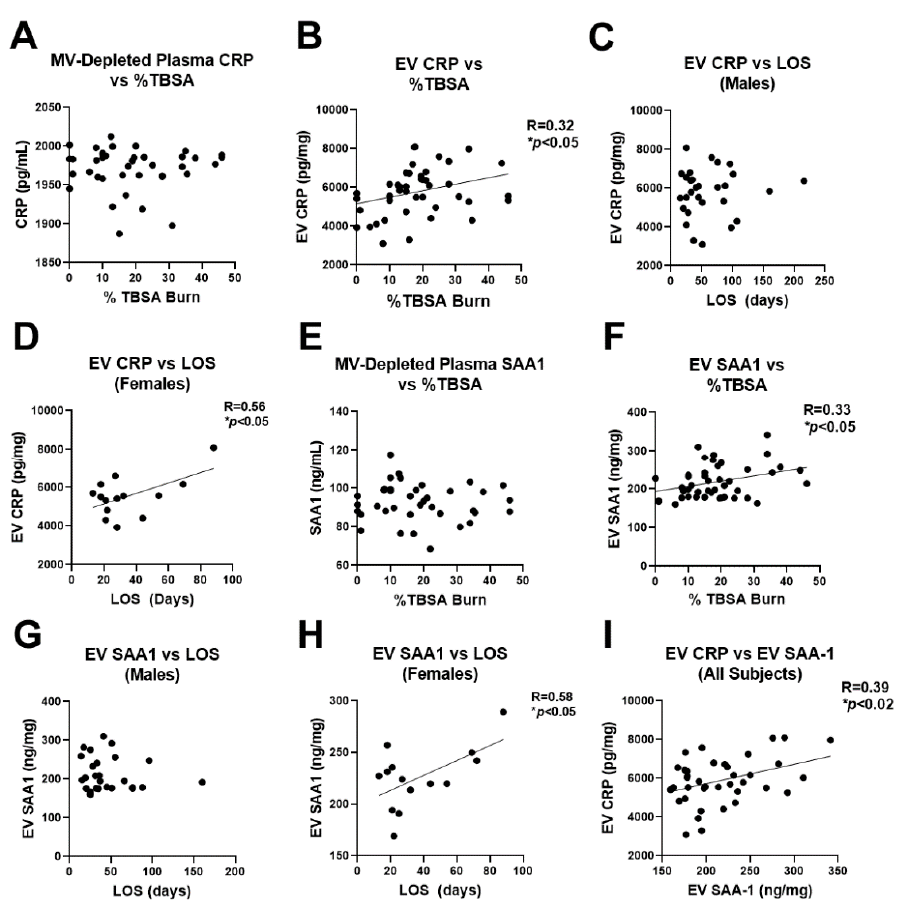
Figure 7. Association of EV CRP and SAA-1 in EVs with length of hospital stay in severe burn injury. EVs were isolated from 50 human burn patients and levels of CRP ( A – D ) and SAA1 ( E – H ) measured